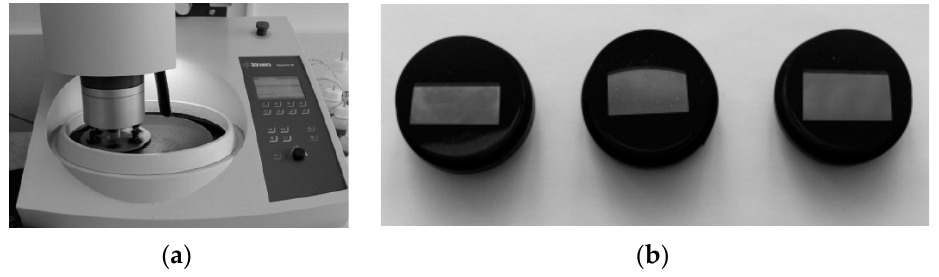
Figure 12. Preparation of samples for research: ( a )—polishing process, ( b )—finished group of sam- ples.